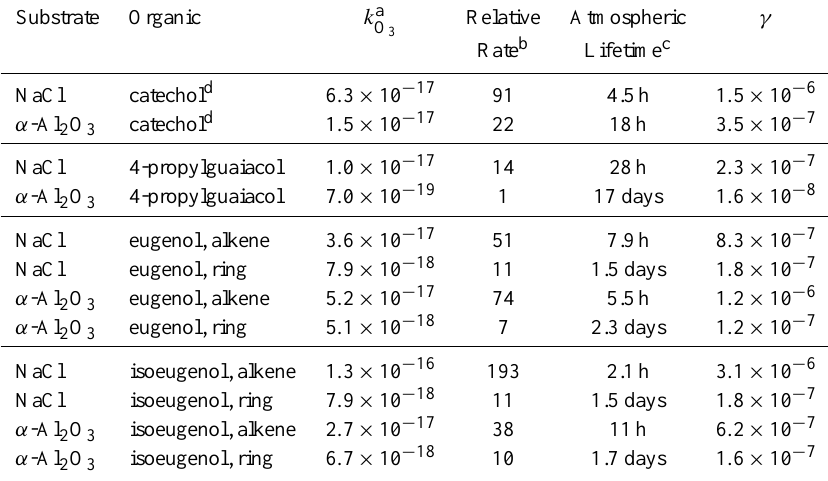
Table 2. Relative ozonolysis kinetics.